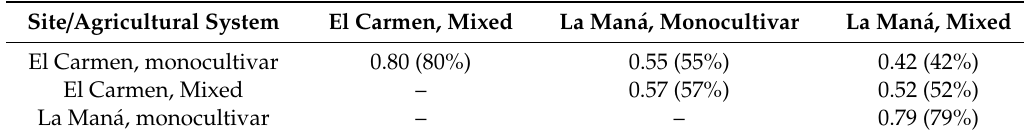
Table 7. Jaccard index of similarity (%) based on di ff erent arthropod families between sites and production systems in 2014.